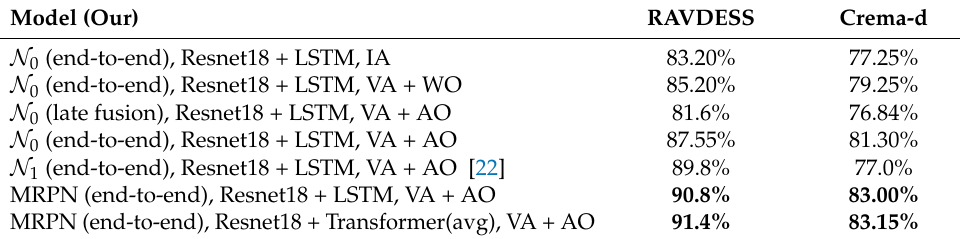
Table 4. Comparison of our fusion models with others recent solutions. Options used: IA—image augmentation; WO—without audio overlapping; VA—video frames augmentation; and AO—audio overlapping; X symbol—there is no report from authors for the given